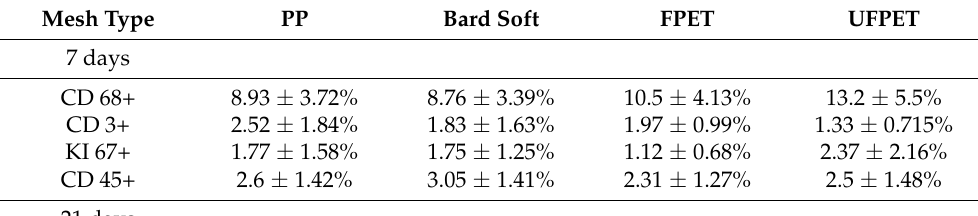
Figure 5. Immuno-histologic characterization of foreign body response after 7 days showing marker-positive cells in the region of interest surrounding the subcutaneously implanted meshes. Kruskal–Wallis comparisons did not reach the significance threshold of p < 0.05. ( a ) CD 68 positive (macrophages), ( b ) CD 3 positive (T-lymphocytes), ( c ) KI 67 positive (proliferation), ( d ) CD 45 positive (leukocytes). Table 4. Descriptive statistics of the immuno-histologic characterization of foreign body responses after 7 and 21 days. Kruskal–Wallis comparisons did not reach the significance threshold of p < 0.05. Mesh